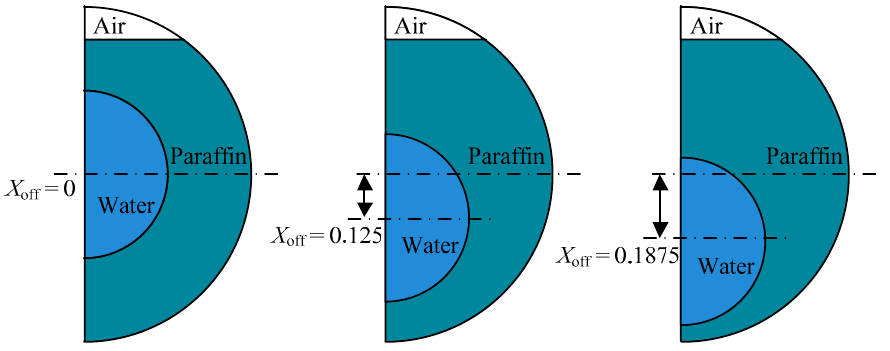
Figure 4. The schematic of the LHS unit with varying eccentricity.